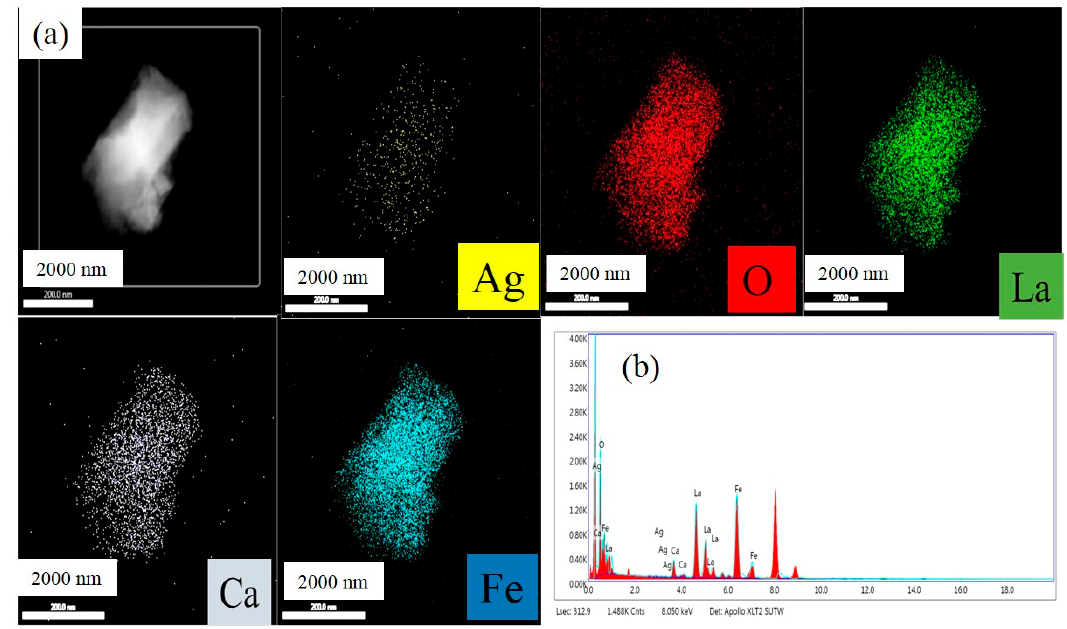
Figure 4. Typical TEM ( a ) and EDS elemental mapping and EDS spectra ( b ) of the LCFA powder crushed from LCFA hollow fiber membrane (sintered at 1250 °C; all magnification bar size at 100 nm).